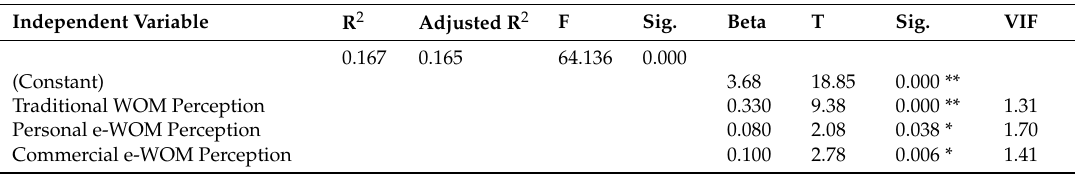
Table 3. The effects of Traditional and eWOM Perceptions on Perceived Destination Image.